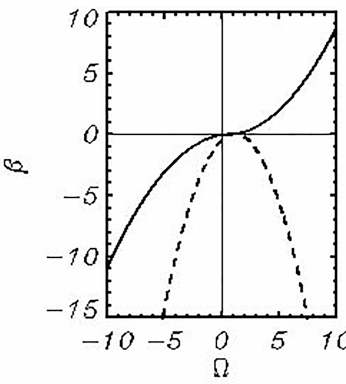
Figure 1. Real (dashed curve) and imaginary (solid curve) parts of the β